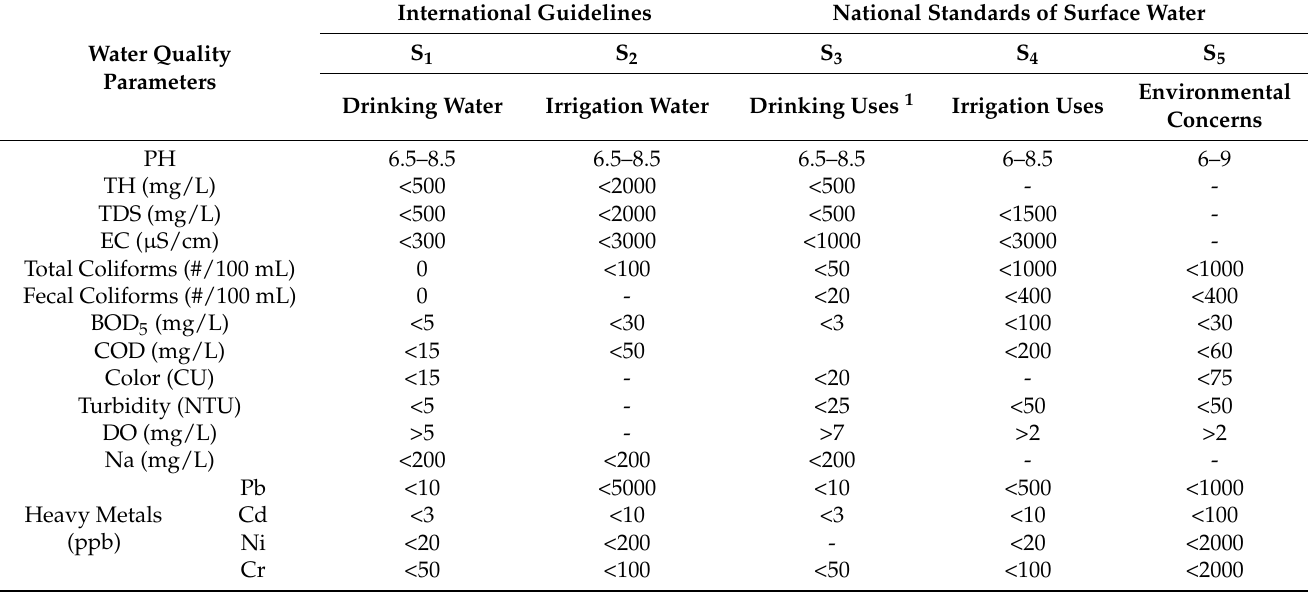
Table 1. The utilized national and international water quality standards. Standards refer to (i) S 1 : WHO [33] guidelines for drinking water quality, (ii) S 2 : FAO guidelines [43] for agricultural water quality, and national standards [42] of (iii) S 3